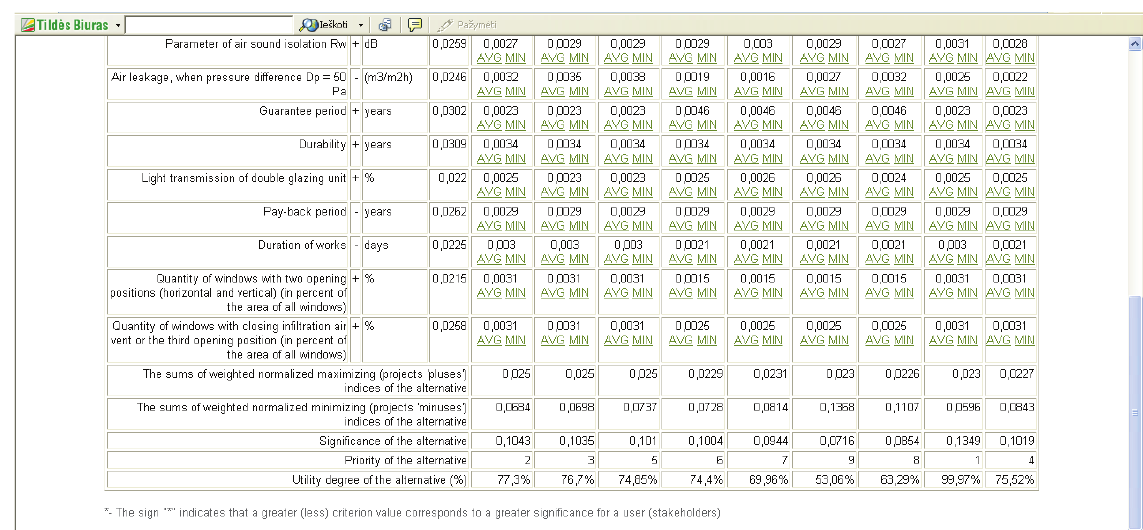
table 2. fragment of multiple criteria analysis of the